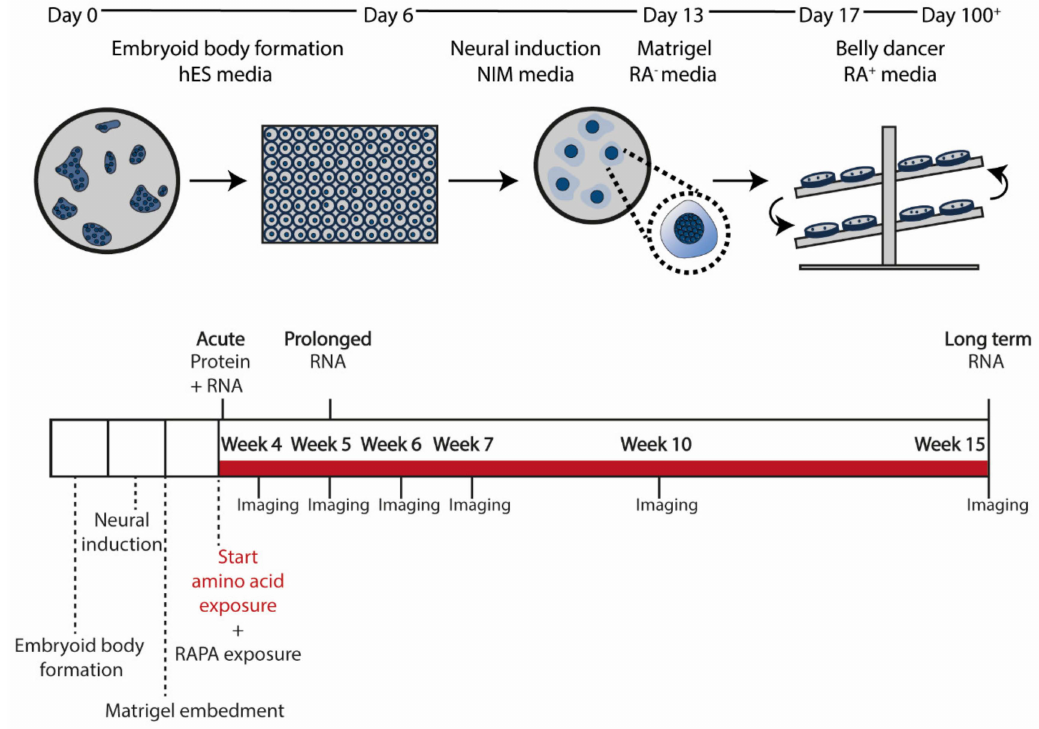
Figure 1. Methodological set-up. A schematic representation of the cerebral organoid protocol (based on Lancaster et al., 2013, with adaptations from Ormel et al., 2018) and experimental set-up. From the start of week 4, organoids were exposed to rapamycin, the AAs His, Lys, and Thr (10 mM or 50 mM), or control medium and either harvested after acute exposure (after 1 h) for protein and RNA isolation or kept in culture for chronic exposure. Organoid size was followed through bright-field imaging at the end of week 4, week 5, week 6, week 7, and week 10. Organoids were harvested for RNA isolation after prolonged (week 5) and long-term (week 15) AA exposure. Harvesting always occurred 1 h after medium